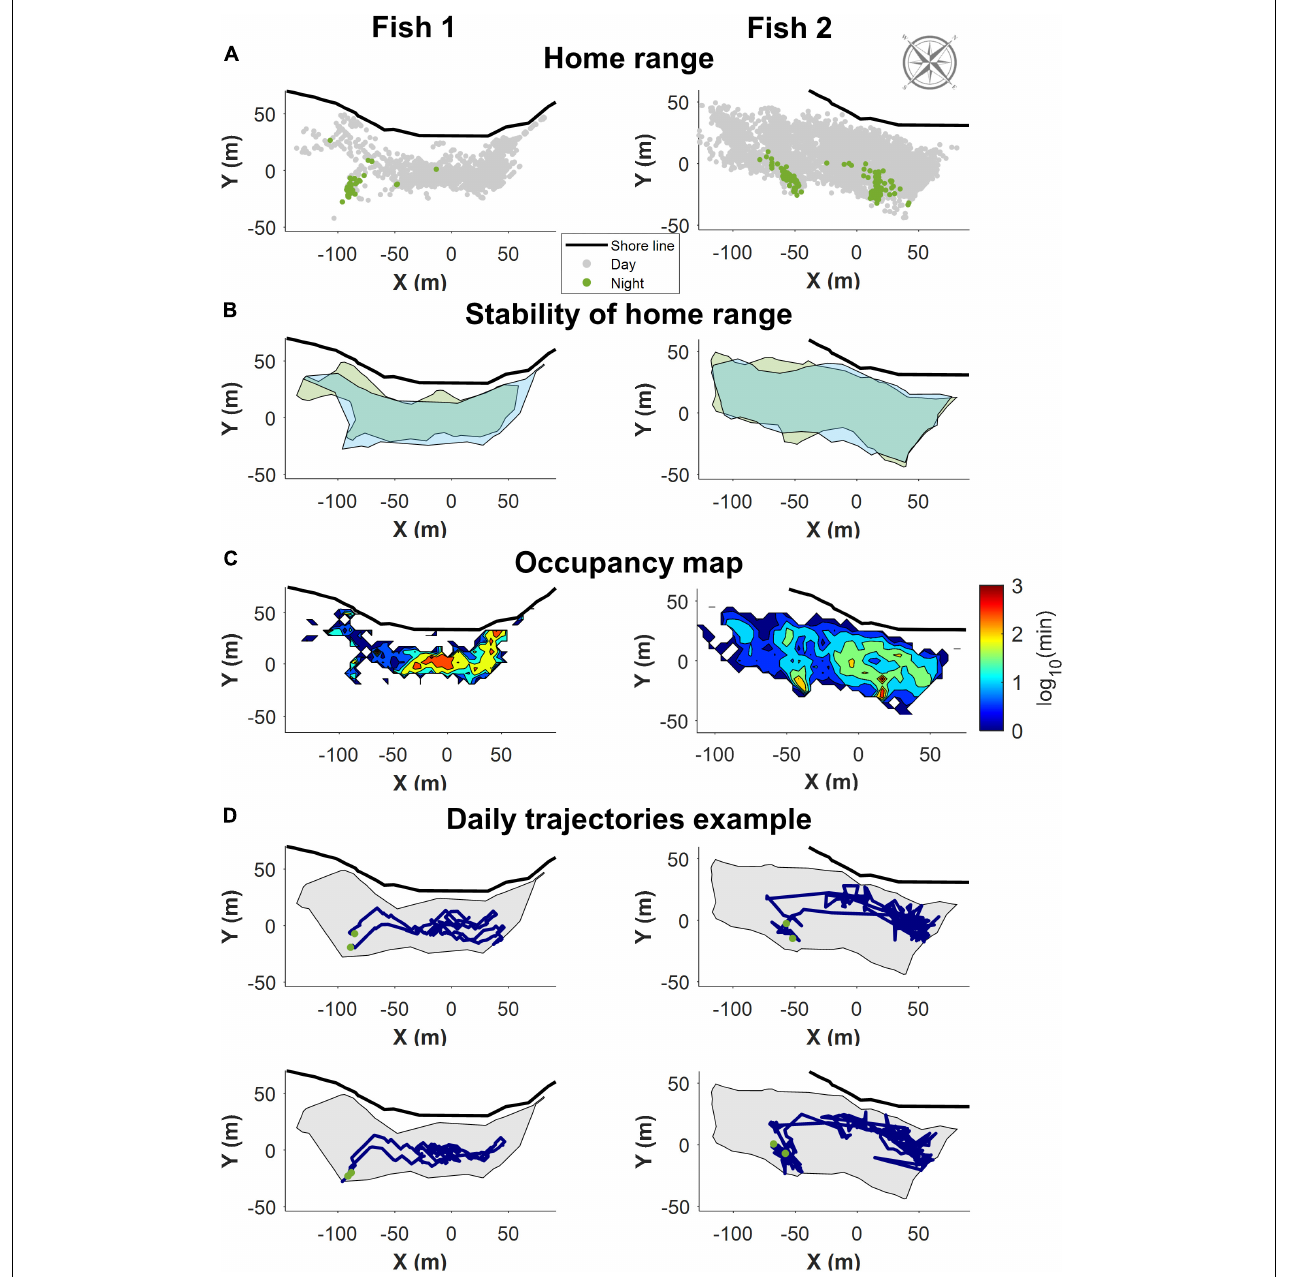
FIGURE 3 | Example of the home range trajectory characteristics of two fish with data obtained through the first of the positioning algorithms. All figures are shown along with the relevant section of shoreline and compass. (A) All recorded positions for the fish. In gray are the positions during the day, in green the night-time position. The fish slept in a restricted area in the home range. (B) The home range remained stable over time. Boundaries of the area covered the first few days of data in green, and the last few days in blue. (C) A heat map visualizing a normalized logarithmic scale of the occupancy map in different areas of the home range. (D) Two examples of daily trajectories for each fish. Green dots represent the start and end points for each day. The gray background is the boundary delineating the home range.